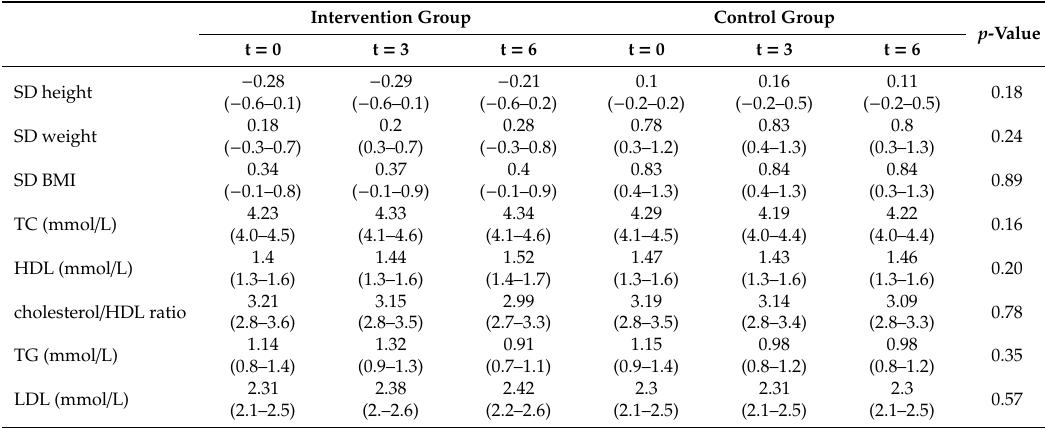
Table 3. Growth parameters and lipid profile (both with 95% CI) during the 6-month intervention (mixed model analysis). p -values express the di ff erences between both groups. Intervention Group Control